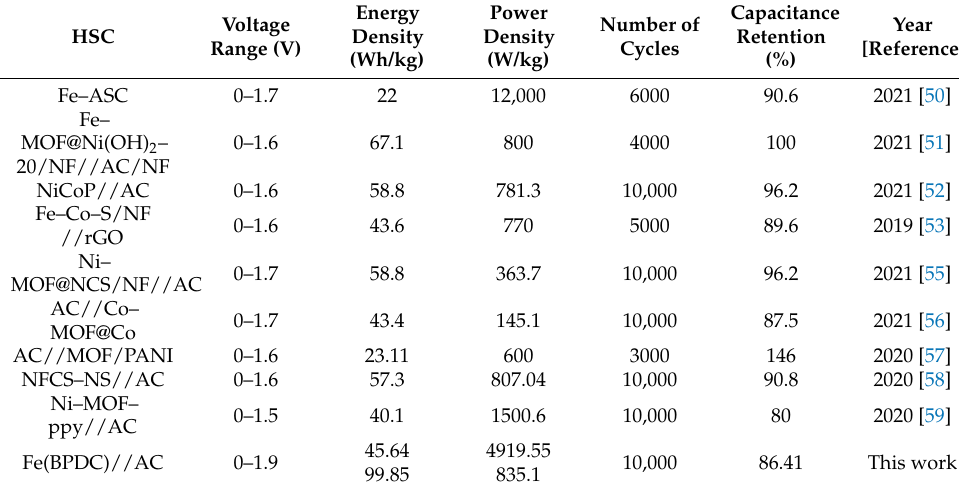
Table 1. Comparison of Fe(BPDC)//AC with recently published MOFs